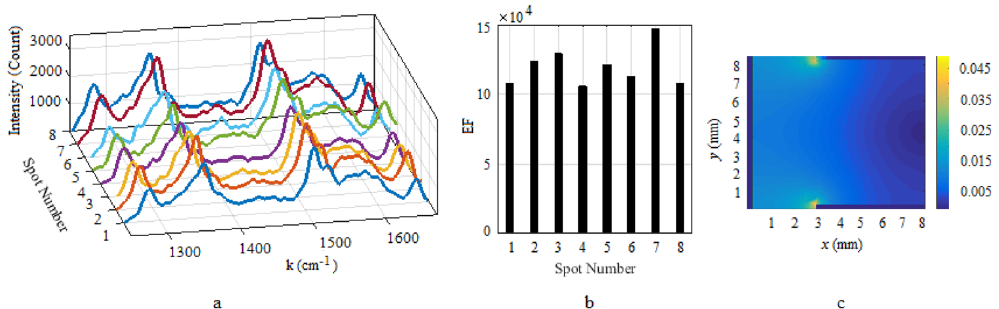
Figure 6. Left: The recorded Raman spectrum from eight random spots on the Cu substrate. Middle: Comparison of EF through these spots. Calculated RSD of the EF variation for the Raman peak of 1509 cm − 1 is 12 percent. The spectrums were recorded with 90 seconds of electrolysis time and RhB of concentration of 5 μ M . Right: Simulated current distribution over the cross section of the cuvette. Anode is indicated with solid thick line at at x =